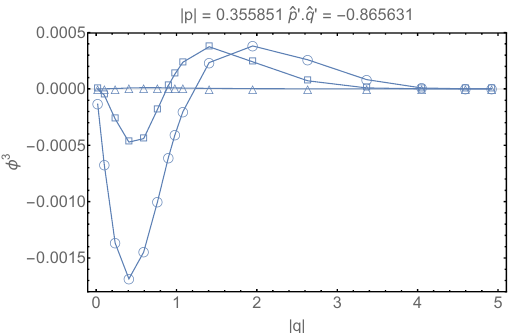
Figure 2. Cross section through selected scalar functions that define the bound state of 3 He. Circles, squares and triangles correspond to T = 1